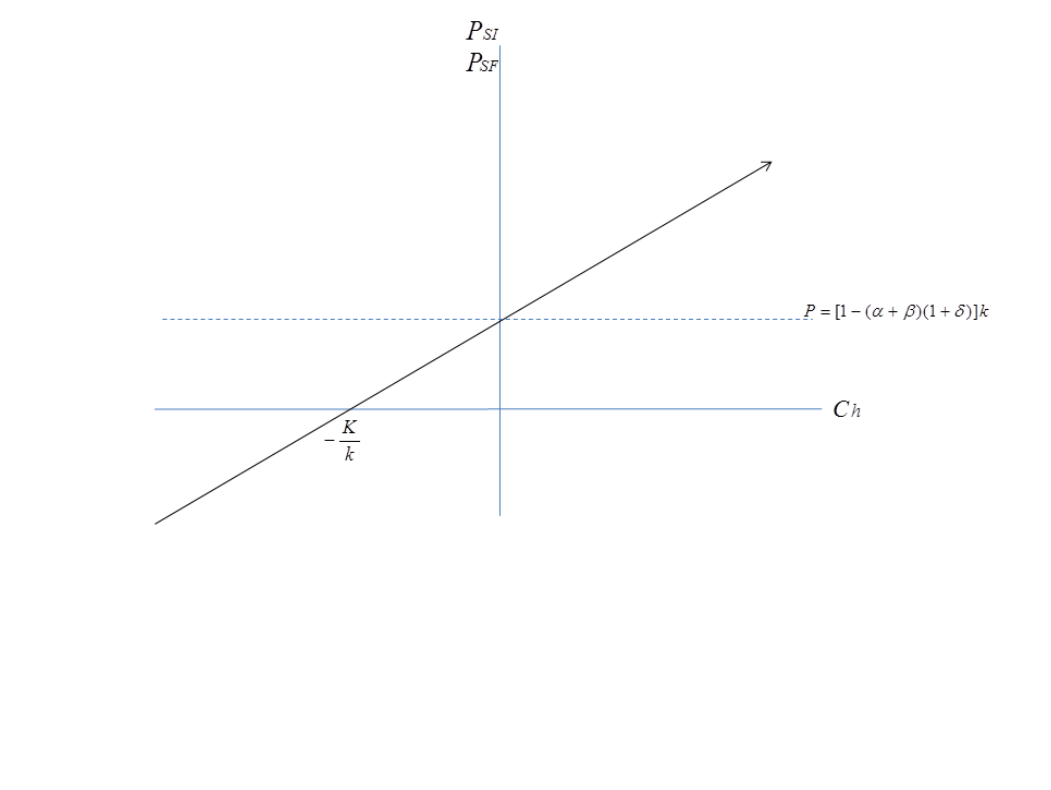
Figure 1: The optimal price for SI and SF and the